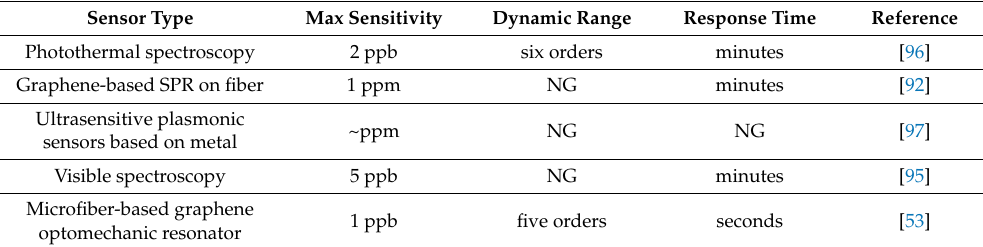
Table 2. Major progress in optical graphene gas sensors based on